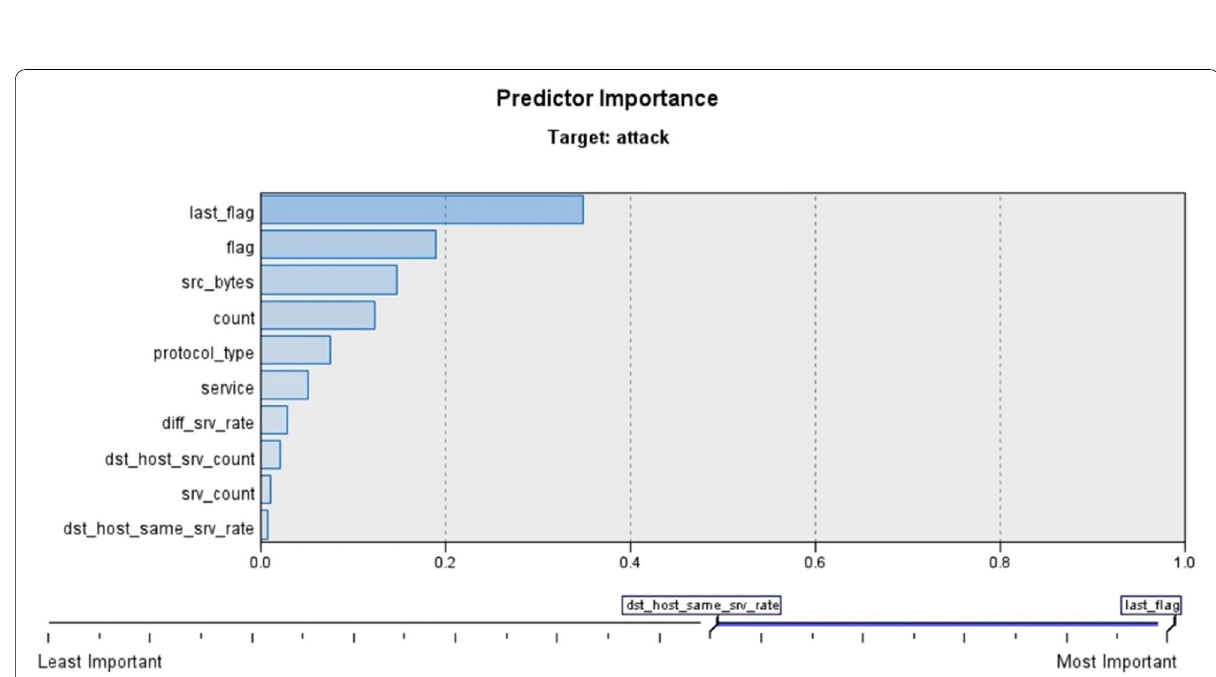
Fig. 3 C5.0 model